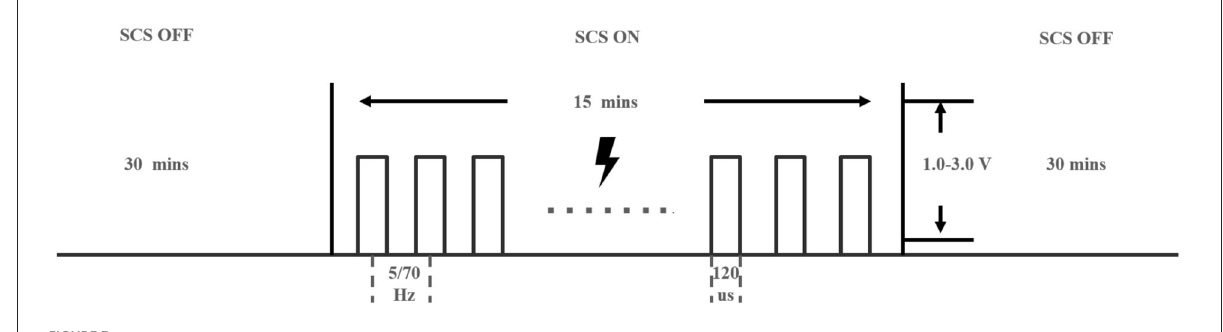
FIGURE3 The stimulation paradigm of